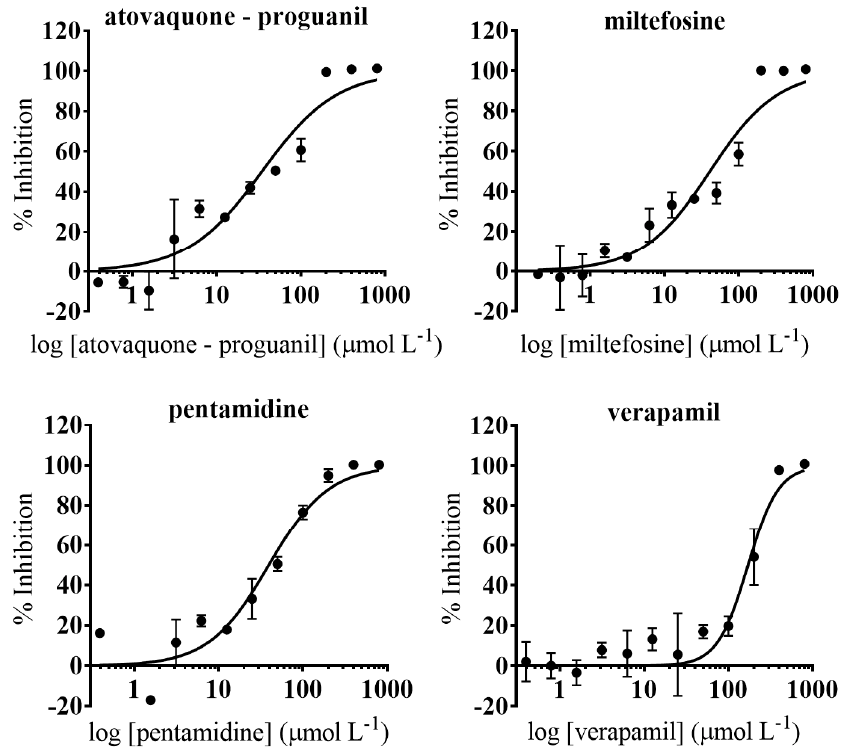
Figure 5. Dose-response curves of the four selected drugs with confirmed anti- T. cruzi activity assessed in HepG2 cell toxicity assays. Graphs represent mean values and SD results of at least three independent replicas.